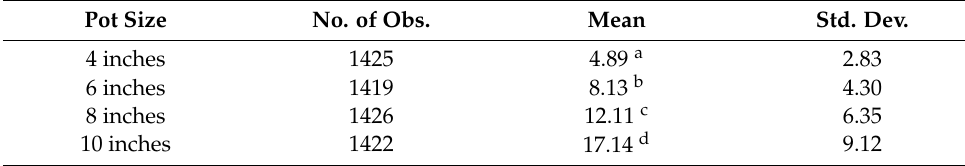
Means denoted by a different letter indicate significant differences between pot sizes ( p ≤ 0.05). Significant differences were observed among the four pot sizes of white poinsettia “Alpina”. Respondents’ willingness to pay ranged from USD 4.85 to USD 17.27 per pot for the 4-inch to 10-inch potted white poinsettias (Table 5). Table 5. Willingness to pay for white poinsettia “Alpina” by pot size. Pot Size No. of Obs. Mean Std. Dev.